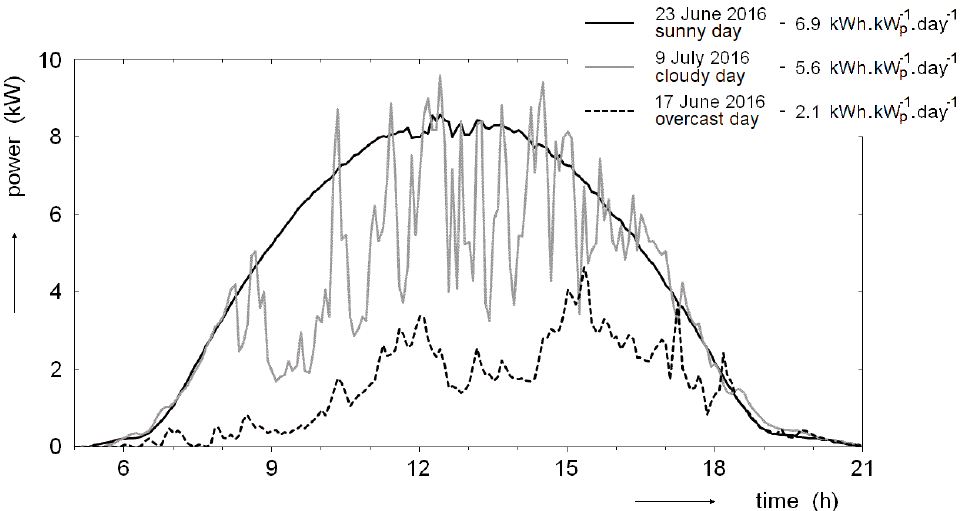
Figure 5. Dependence of the instantaneous power relative to time during the three selected days in 2016.